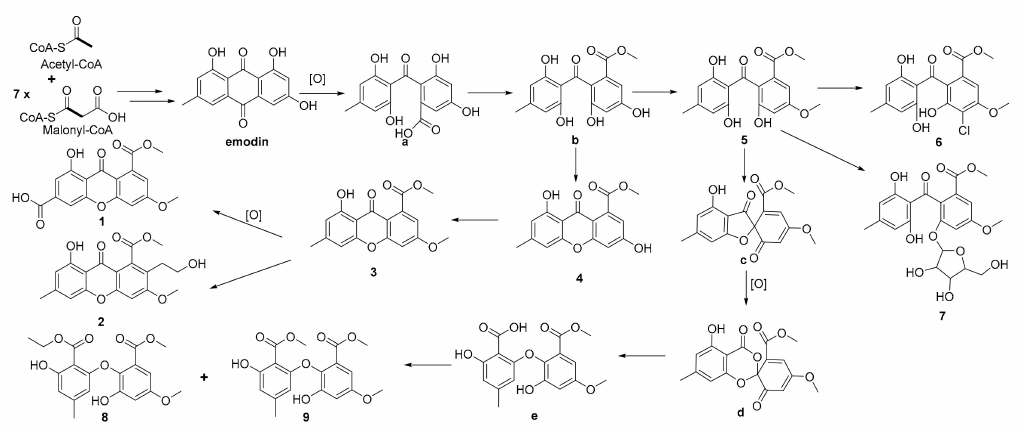
Figure 3. Proposed biosynthetic pathways of compounds 1 – 9